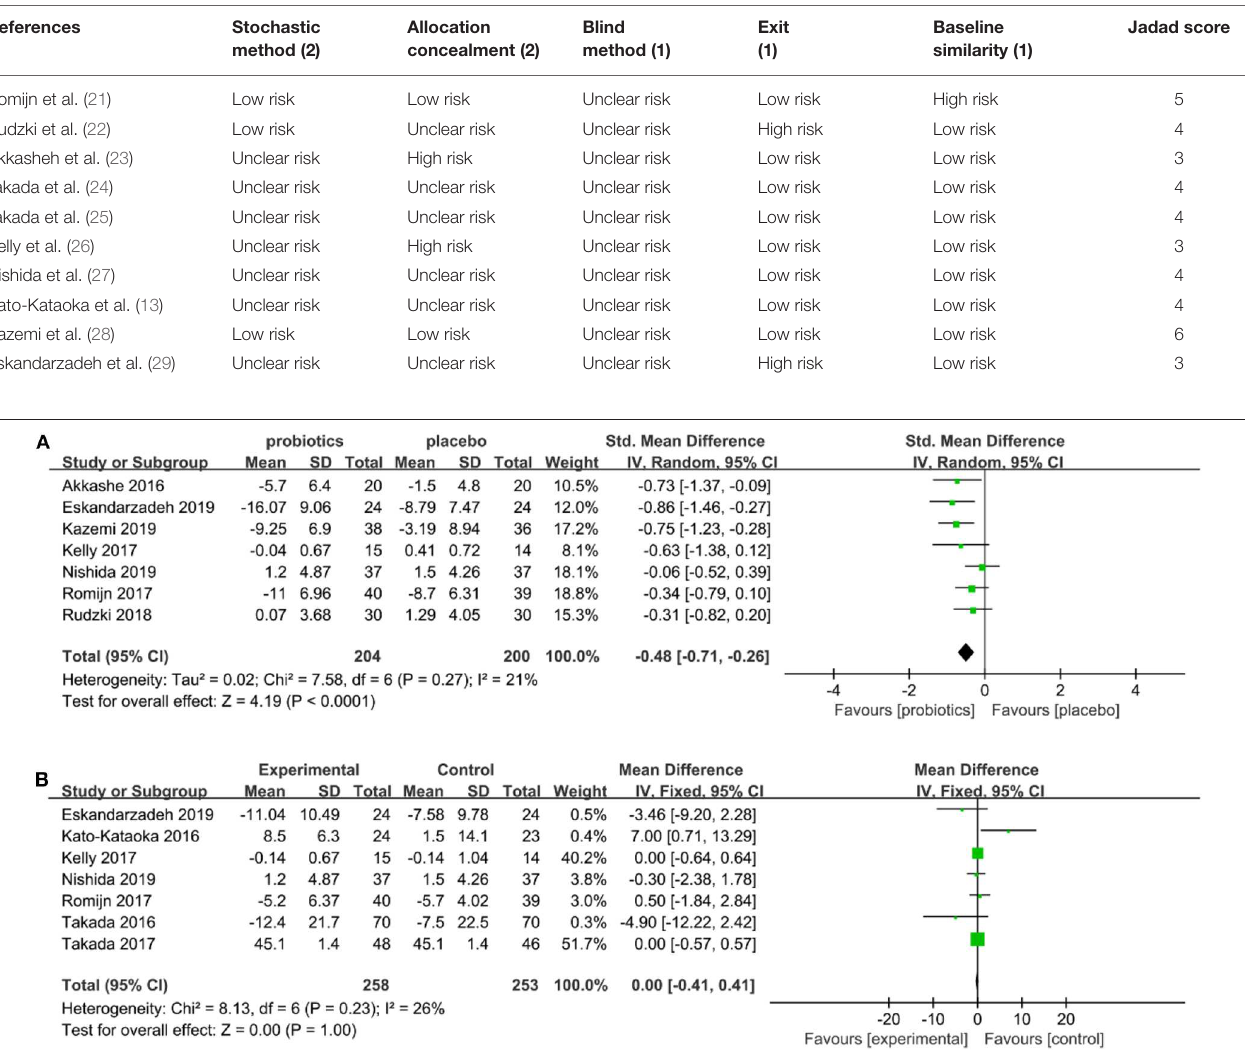
TABLE 2 | Quality assessment of clinical trials meta-analysis using modified Jadad evaluation scale.